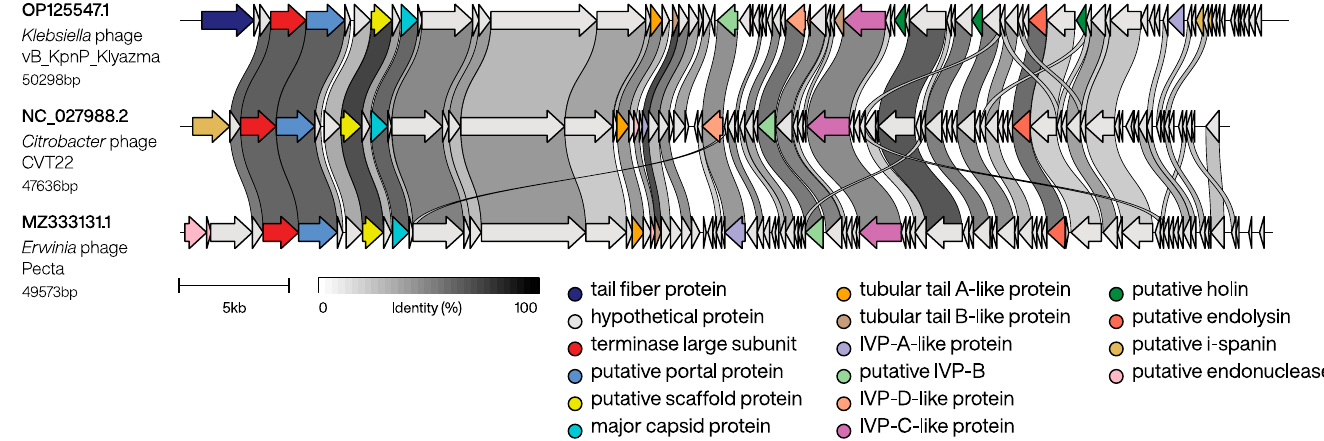
Figure 2. Pairwise genome comparison of phages vB_KpnP_Klyazma, CVT22, and Pecta.